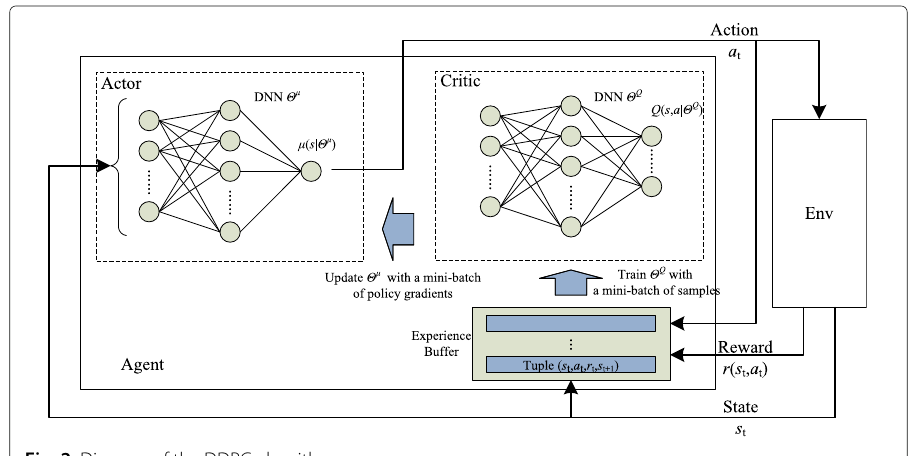
Fig. 2 Diagram of the DDPG algorithm